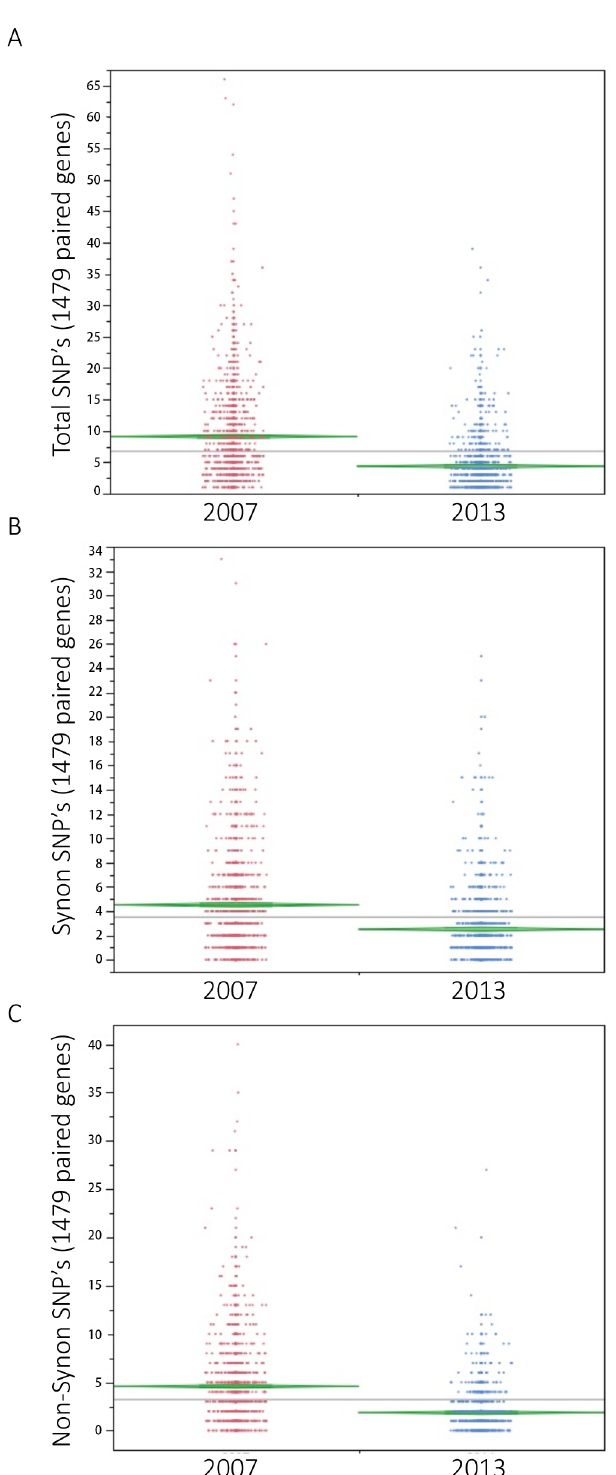
Fig 3. SNP positions within 1479 shared genes in N . ceranae parasites collected in 2007 and 2013. A: The average number of SNP decreased from 9.1 per gene to 4.36 per gene (p < 0.001). B: Within the total SNP count, the average number of synonymous substitutions decreased from 4.5 in 2007 to 2.81 in 2013. C: The average non-synonomous SNP level dropped from 4.58 in 2007 to 1.85 in 2013. X axis represents two sample groups. Y axis represents number of SNP